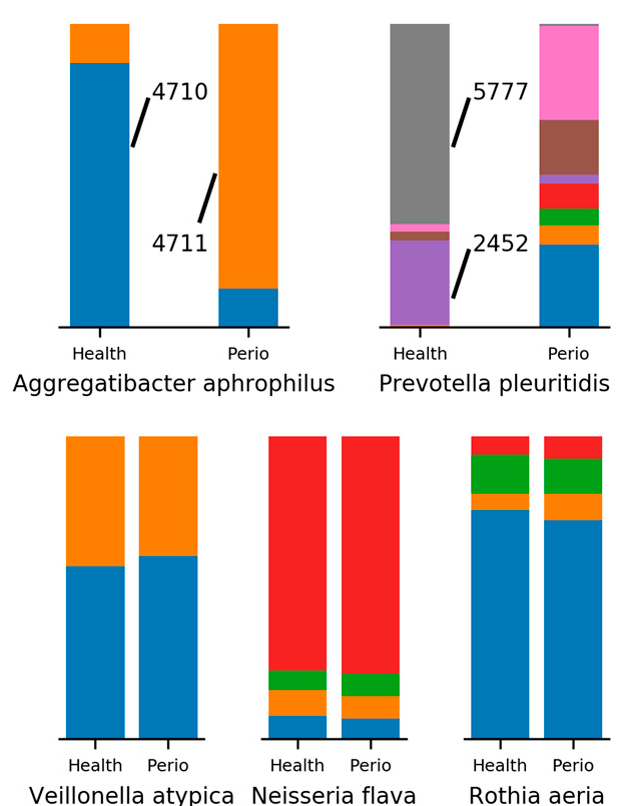
Figure 5. Minimum entropy decomposition (MED) analysis of 5 OTUs with similar nodes. Examples of subgingival bacteria for which there are limited or no differences in the number and distribution of MED nodes (e.g., potential subspecies) in periodontal health versus disease.